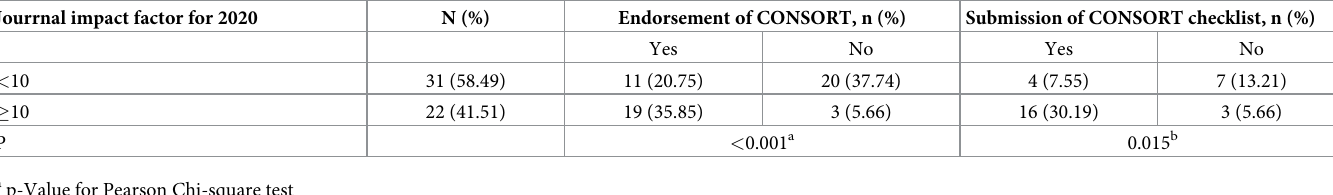
Table 4. Relationship between journal impact factor and endorsement of